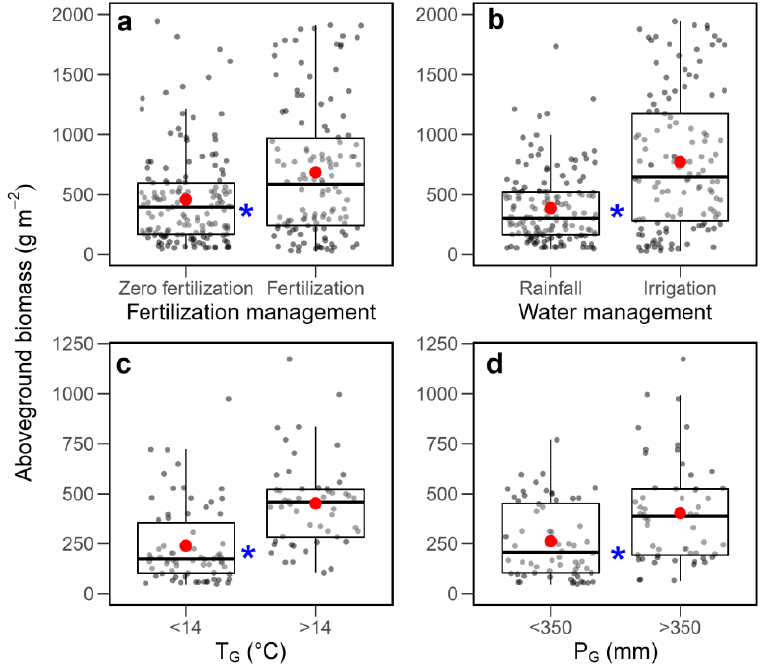
Figure 3. AGB as impacted by management and environmental factors. ( a ): fertilization; ( b ): water management; ( c ): mean temperature during plant growing seasons (April – October; TG); ( d ): accumulated precipitation during plant growing seasons (April – October; PG). Red dots show the average, and the boxplots show the median and interquartile range with whiskers extending to 1.5 times the interquartile range. Blue stars between two boxes of AGB indicate significant differences ( p < 0.05) between the two groups of data as determined by t test. Observed AGBs of all species were analyzed in (a) and (b), while only AGB of Medicago sativa under zero fertilization and rainfall conditions were used in (c) and (d).